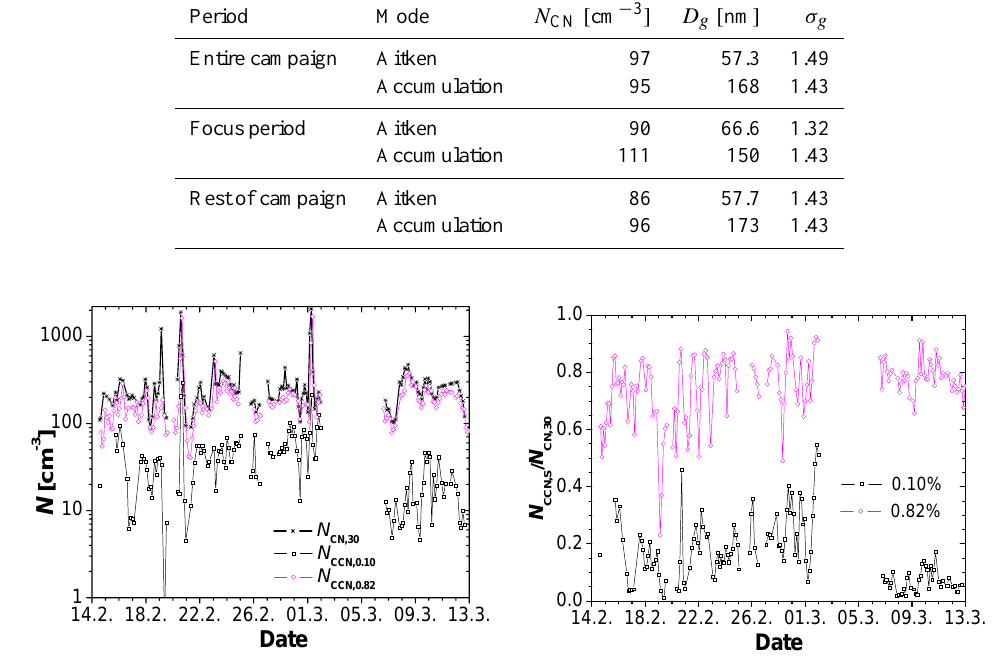
Fig. 7: Time series of the number concentrations of aerosol particles with D > 30 nm ( N CN,30 ) and cloud condensation Fig. 7. Time series of the number concentrations of aerosol particles with D> 30nm ( N CN , 30 ) and cloud condensation nuclei ( N CCN ,S ), nuclei ( N CCN, S ), and of the integral CCN efficiencies ( N CCN, S / N CN,30 ) at different levels of supersaturation ( S = 0.10% and of the integral CCN efficiencies ( N CCN ,S / N CN , 30 ) at different levels of supersaturation ( S =0.10% and 0.82%) plotted against the date and 0.82%) plotted against the date in Feb-Mar 2008 (UTC). in February–March 2008